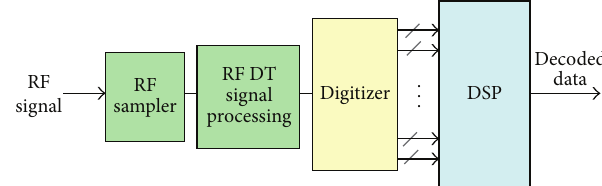
Figure7:AnenvisionedSDRarchitectureenabledbypassiveanalog signal processing.